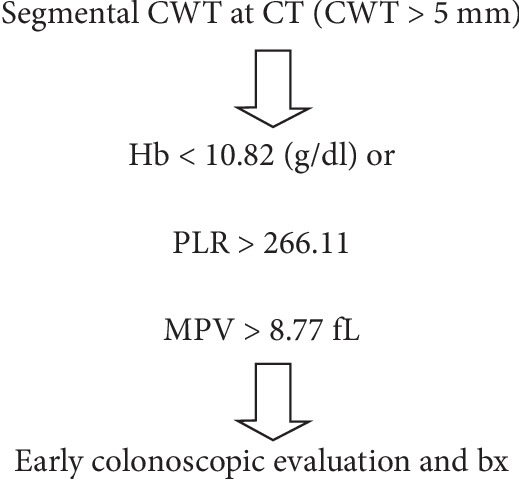
Management tool for colon wall thickening (CWT) to neoplasia with high positive predictive value.